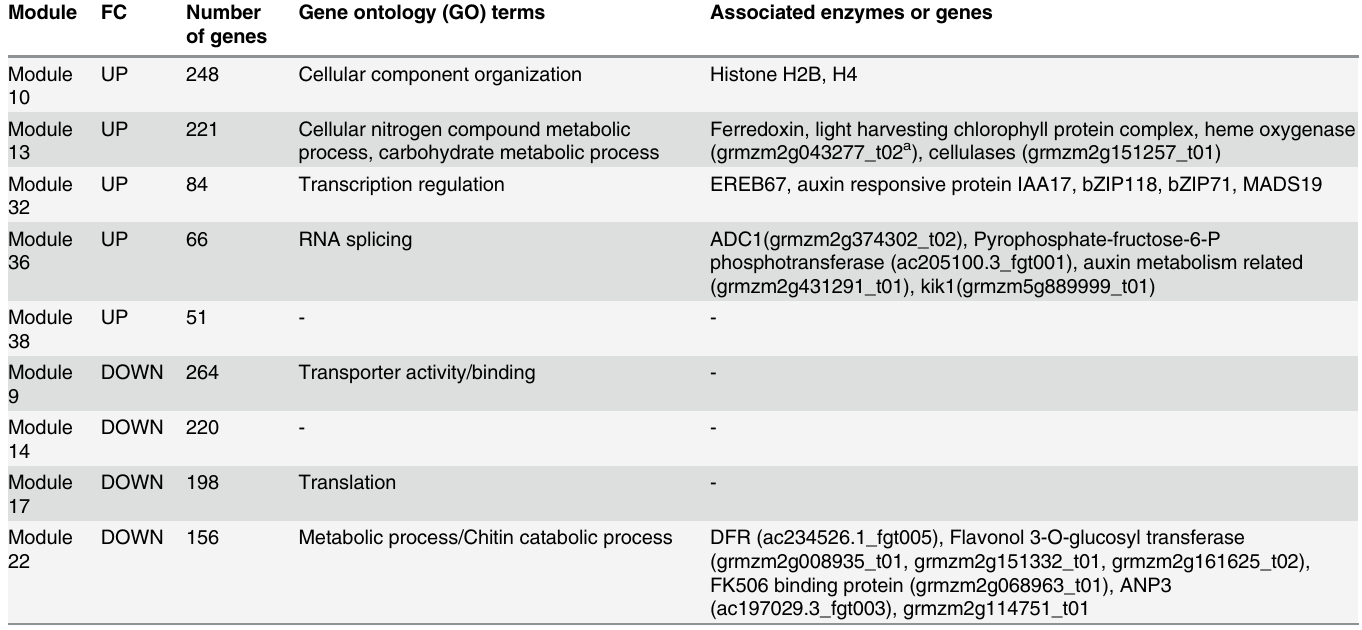
Table 7. Over-represented biological processes of modules significant between high- and low-yielding groups. Biological functions for modules were significant at FDR p-value <